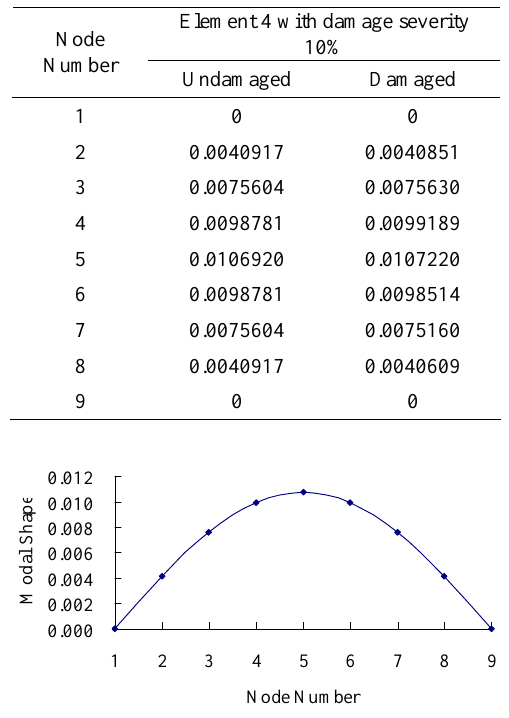
Fig. 4. Modal shapes for undamaged bridge